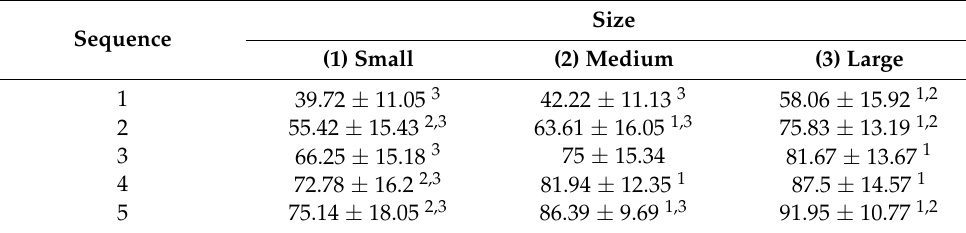
Figure 2. Accuracy (mean ± standard error) of the different conditions (small, medium, and large sizes) as a function of the number of sequences used. Table 3. Accuracy (%, mean ± standard deviation) comparisons between the four different spellers for sequences 1–5.